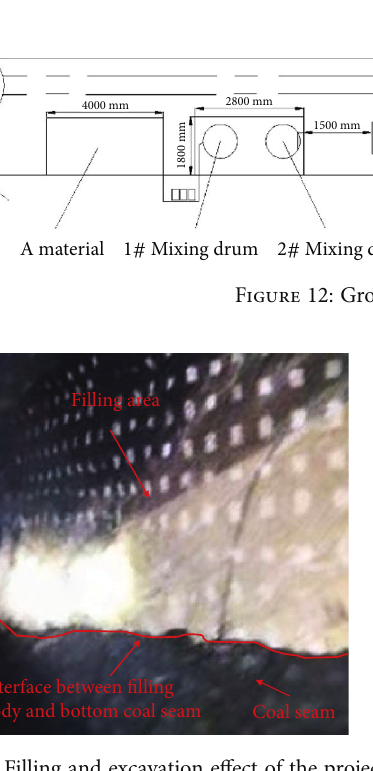
Figure 13: Filling and excavation e ff ect of the project